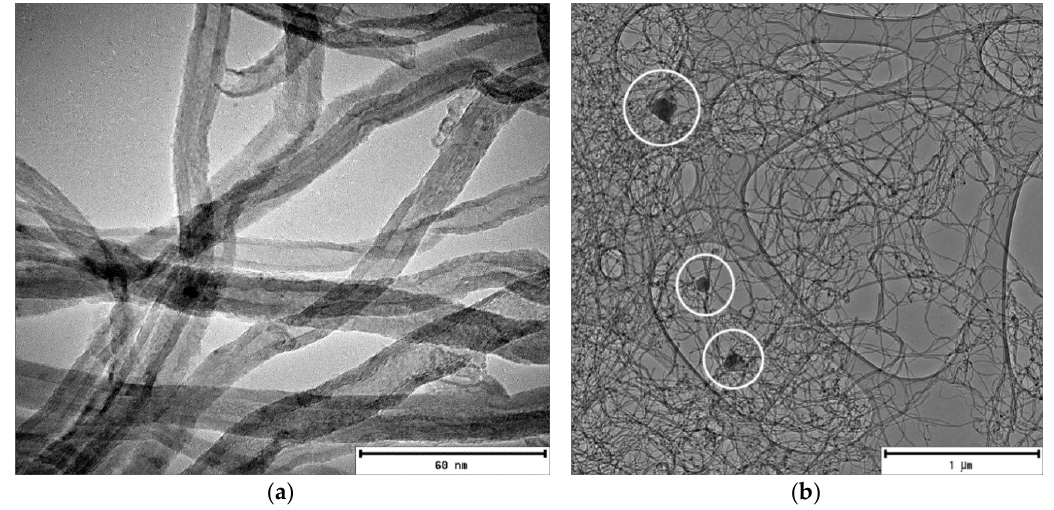
Figure 3. TEM micrograph of CNT supplied by Sigma Aldrich. ( a ) Indicating the morphology of the CNTs at high magnification; ( b ) the white encircled areas indicate lumpy material adhering to the CNTs.